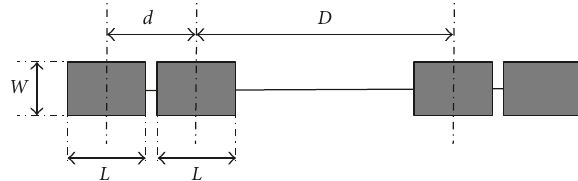
Figure 9: The configuration of the single axle with dual wheels.